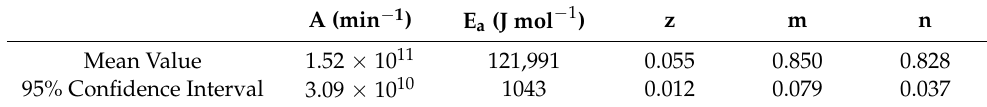
Table 4. Kinetics of the thermal decomposition of PA: final estimate.